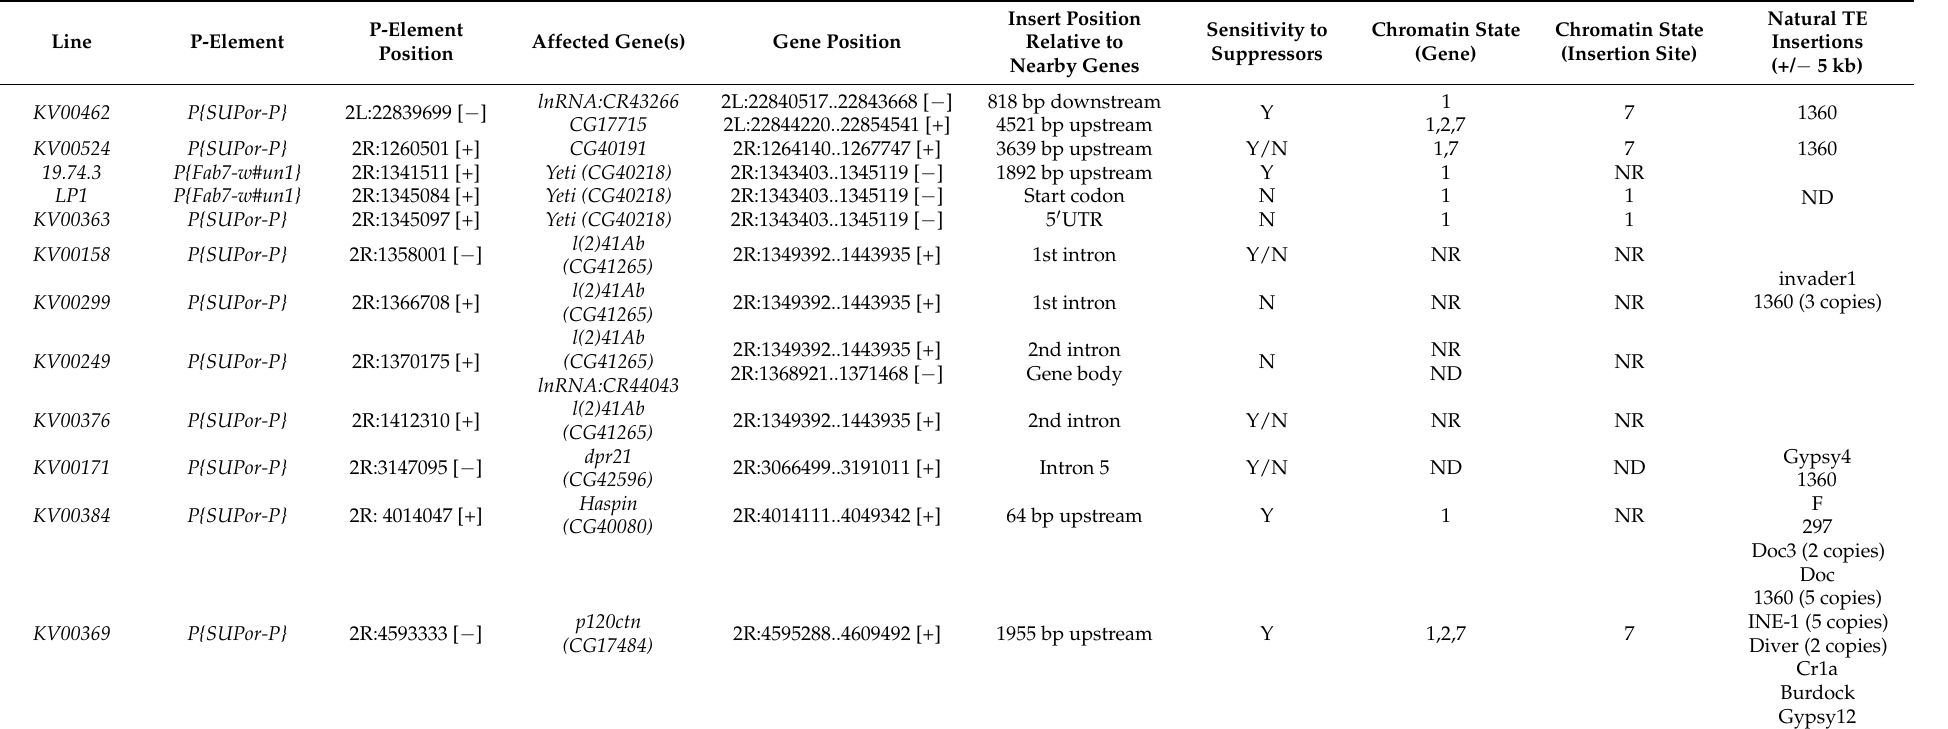
Table 1. Features of the insertion lines described in this